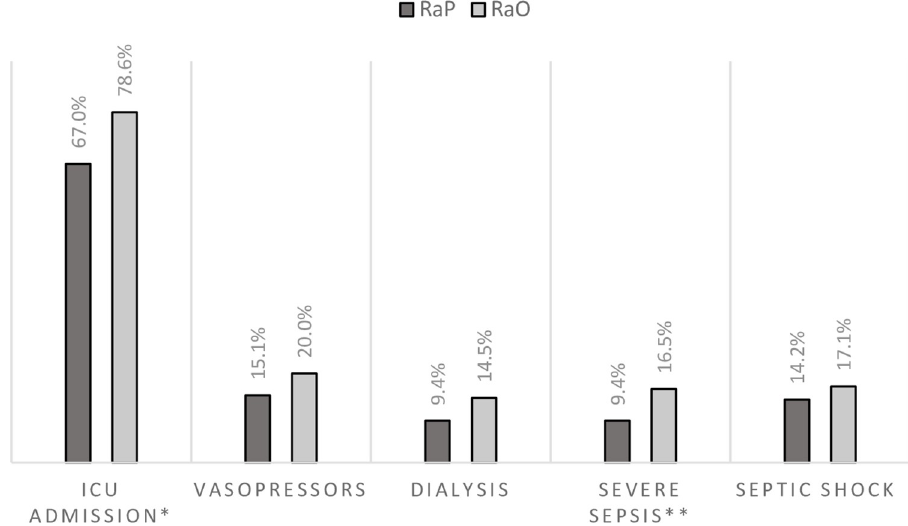
Fig 1. Index hospitalization illness severity measures. RaP = readmission for pneumonia; RaO = readmission for another condition. � P = 0.005. �� P = 0.053.